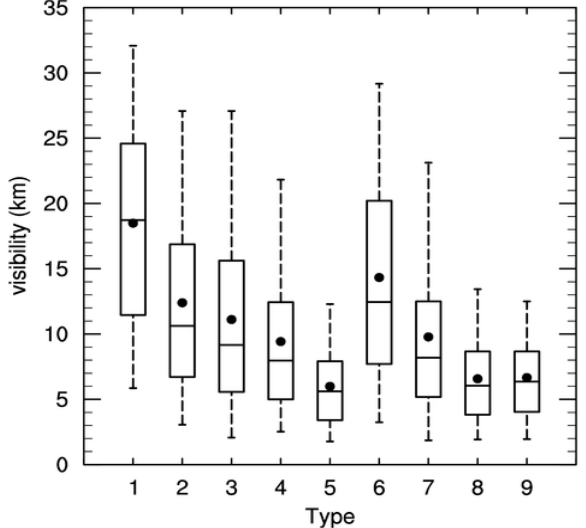
Fig. 6. Daily mean visibility at Beijing airport within the nine clus- ters. The solid dot denotes the mean. The horizontal lines across the box are the averages of the median, first, and third quartiles, respec- tively, while the lower and upper crosses represent the means of the 5th and 95th percentiles, respectively.